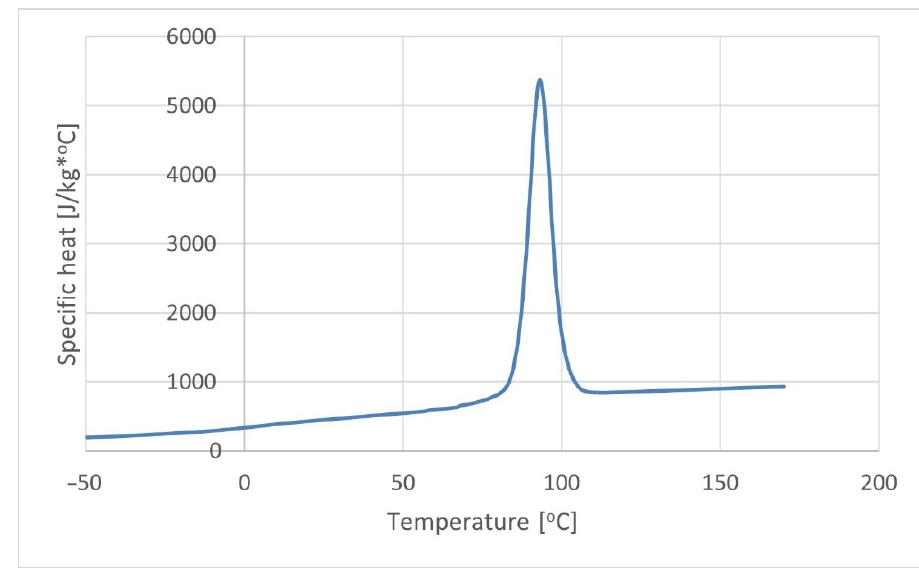
Figure 2. Specific heat of the K30 biocomposite.